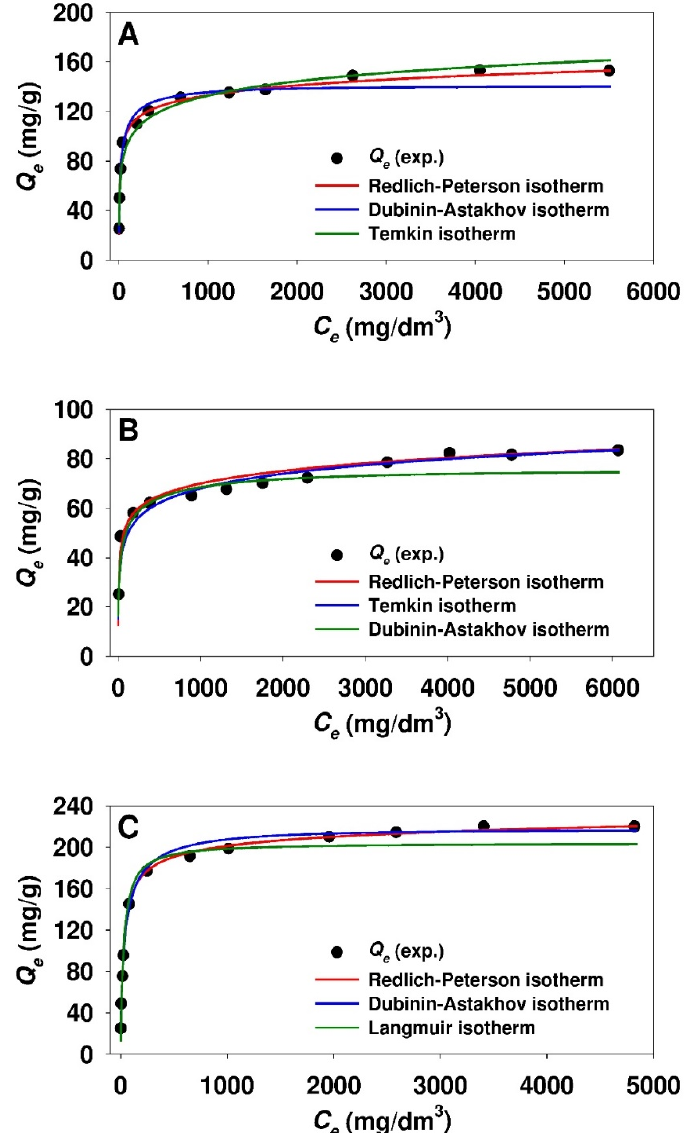
Figure 6. Comparison of experimental and predicted isotherms of ticagrelor adsorption onto: ( A ) SBA-15-(CH 2 ) 3 -SO 3 H, ( B ) PHTS-(CH 2 ) 3 -SO 3 H and ( C ) MCM-41-(CH 2 ) 3 -SO 3 H mesoporous adsorbent. The best fitted isotherm models derived from nonlinear analysis are presented.